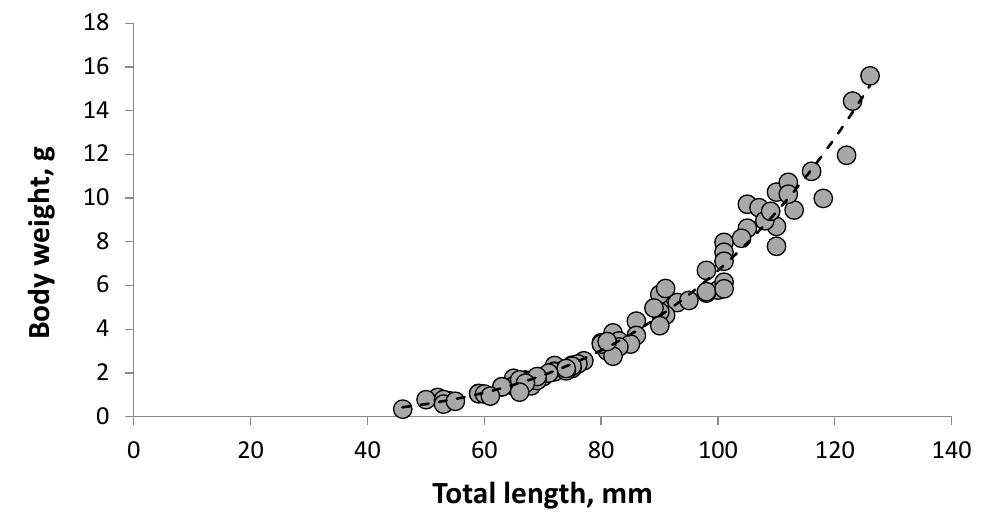
Figure 4. Length–weight relationship of the ribbed sculpin Triglops pingelii in the Kara Sea, September 2019.